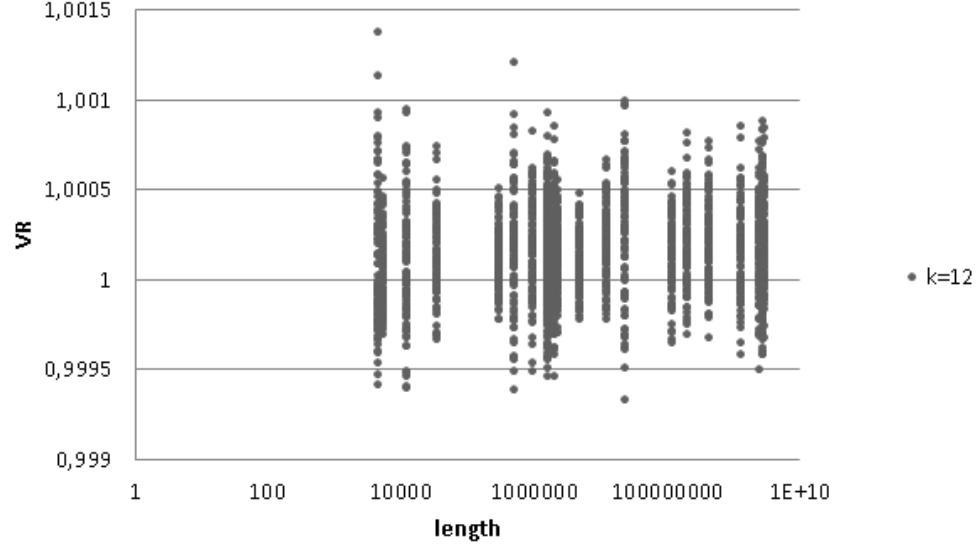
Figure 1: VR values measured in random sequences for k=12 vs sequence